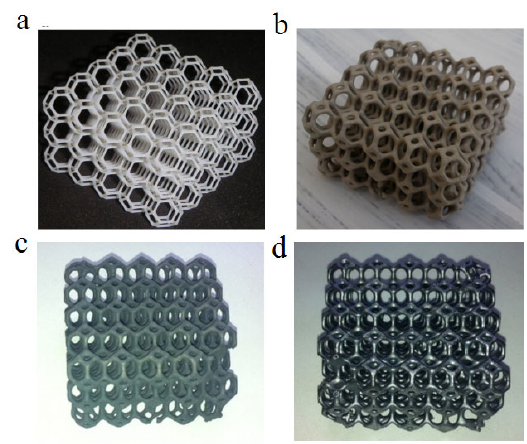
Fig. 6 Indirect additive manufacturing of Si–SiC ceramic: (a) template 3D printing; (b) slurry replication; (c) pyrolysis; (d) silicon infiltration. Reproduced with permission from Ref. [39], © Elsevier B.V. 2012.